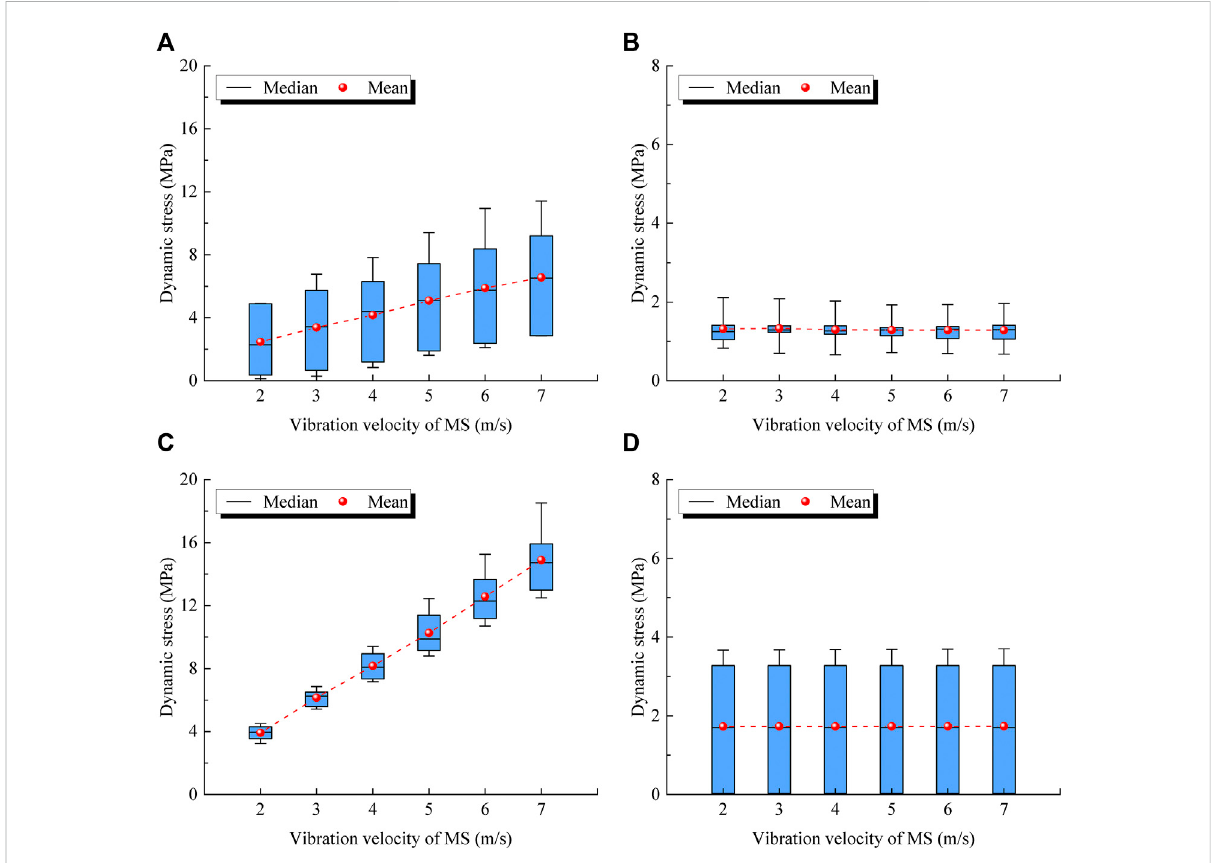
FIGURE 12 Dynamic stresses around the headentry considering different vibration velocities: (A) at the top, (B) at the bottom, (C) at RSR, and (D) at